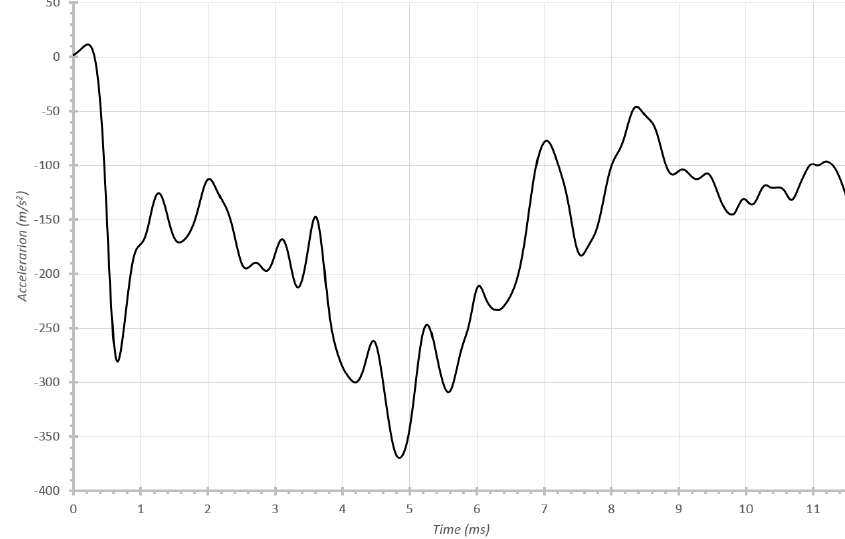
Figure 14. Temporal evolution of acceleration of the ballast with initial impact velocity of 56 km/h.